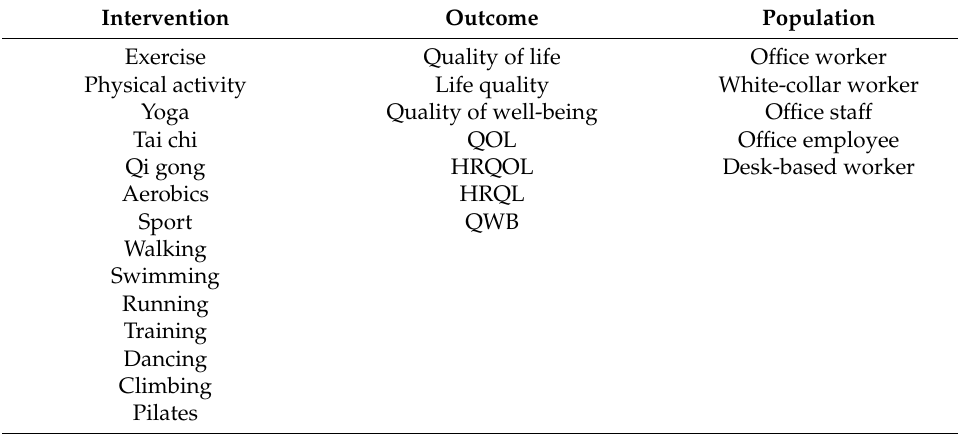
Table A1. Search terms used for literature searches.